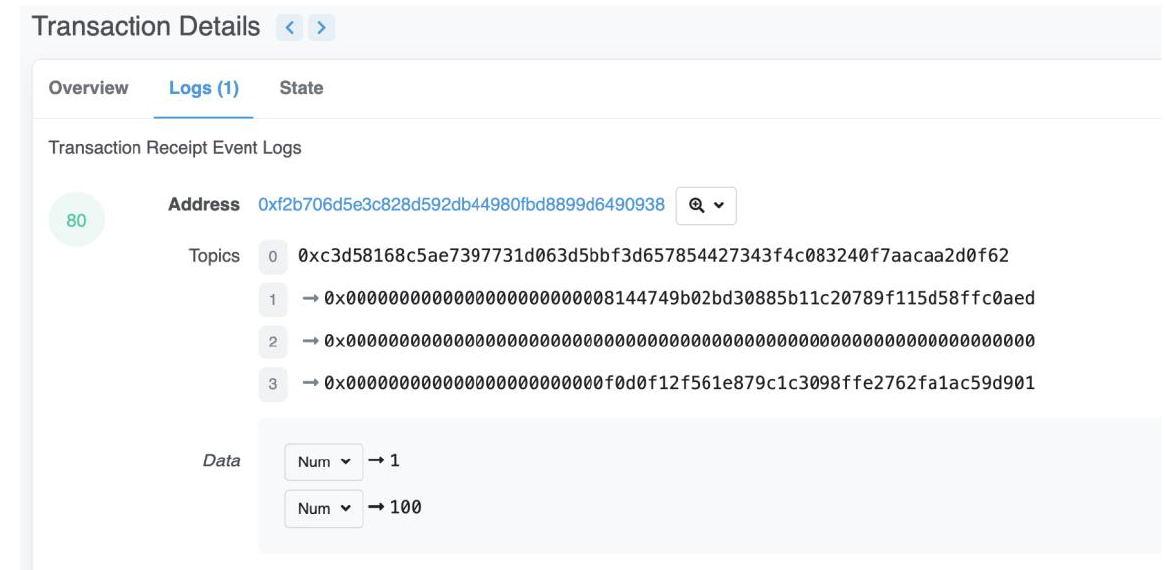
Figure A17. Logs of locking in collateral transaction on